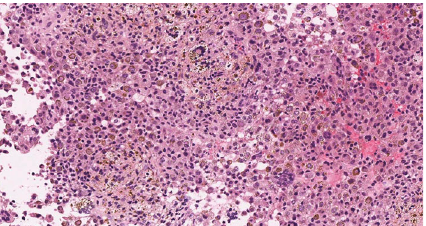
Figure 2: Histology images in the hip prior to pexidartinib treatment. The pretreatment biopsy demonstrating a cellular proliferation of tumor cells composed of abundant hemosiderin laden macrophages, multinucleated giant cells, scattered foam histiocytes, and lymphocytes (H&E